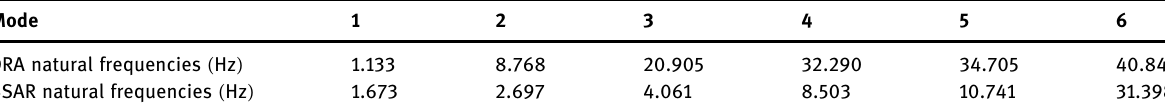
Table 2: Natural frequencies Mode